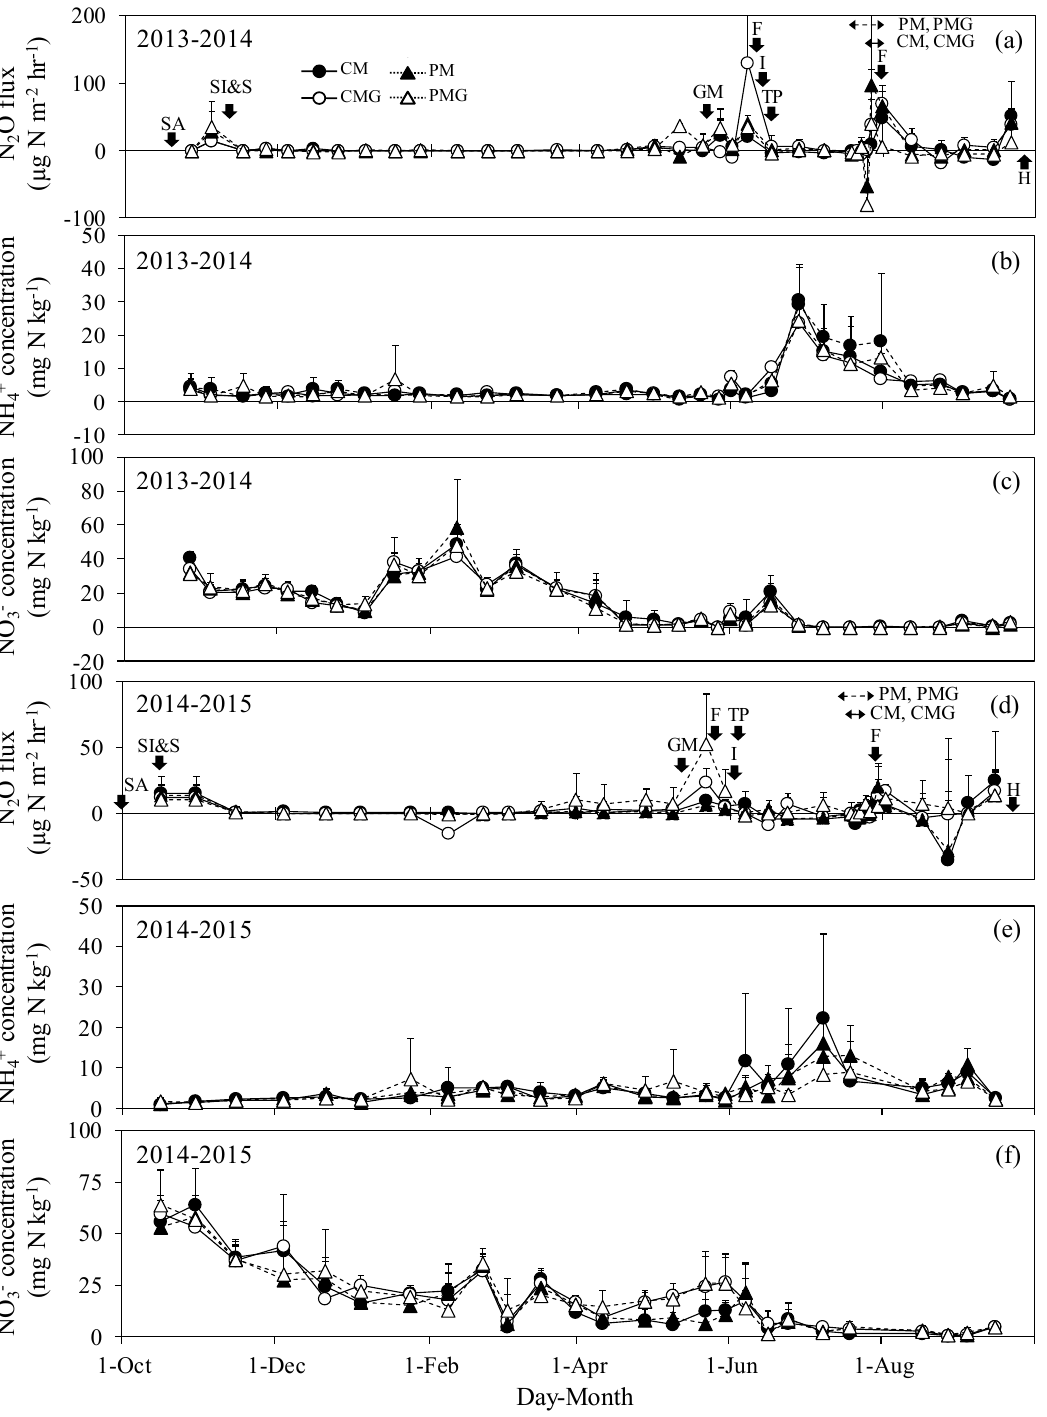
Figure 2. Seasonal variations in N 2 O flux ( a , d ), ammonium (NH 4+ ) concentration ( b , e ), and nitrate (NO 3 − ) concentration ( c , f ). Error bars represent standard deviations. SA, SI, and S represent straw application, incorporation, and seeding, respectively. GM, I, F, TP, and H represent green manure and weeds incorporations, irrigation, fertilization, transplanting, and harvest, respectively. Arrows of the continuous and dotted lines show the periods of mid-season drainage.